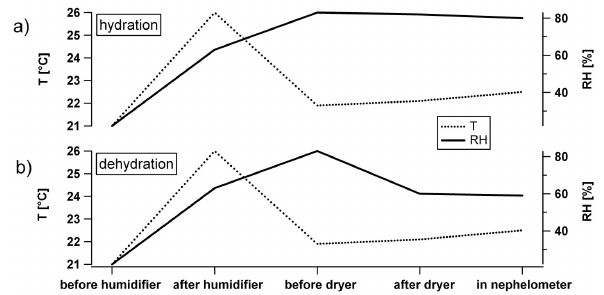
Fig. A1. Example for the evolution of RH and T through the humidified nephelometer with dryer off (a) and dryer on (b) . X-axis refers to T and RH measurement points in Fig. 1.